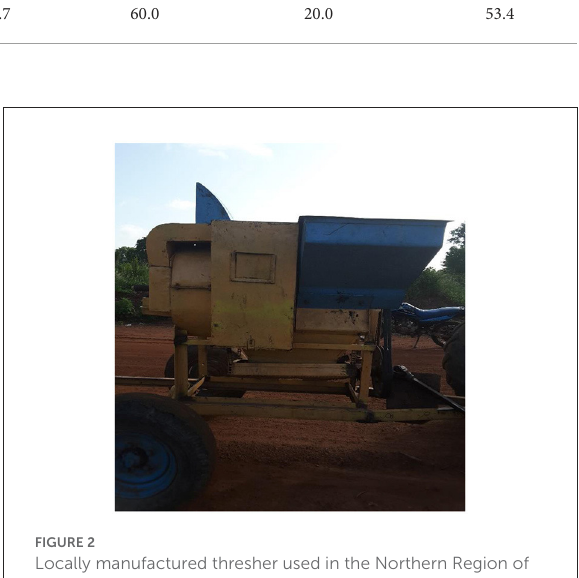
FIGURE2 Locally manufactured thresher used in the Northern Region of Ghana.